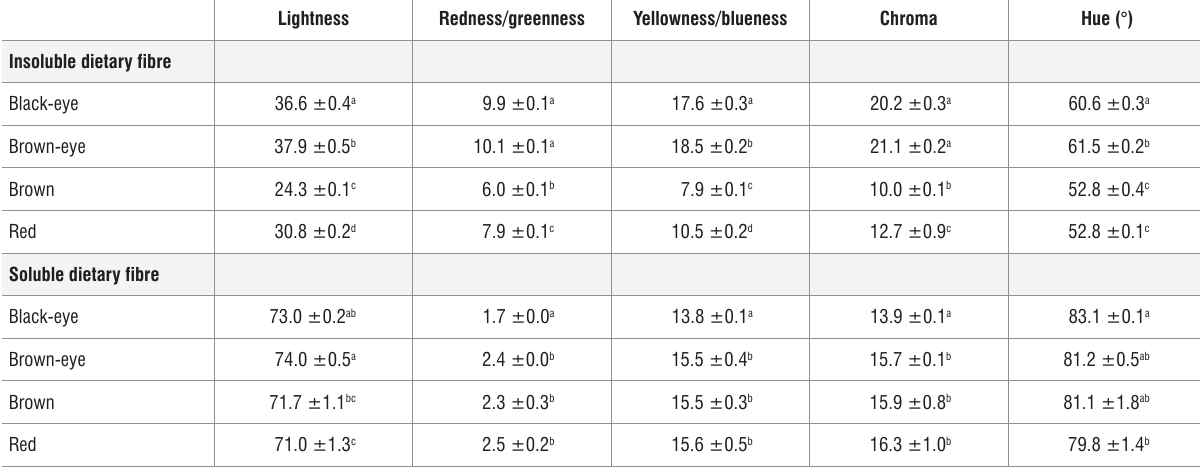
Table 2: Colour attributes of Bambara groundnut dietary